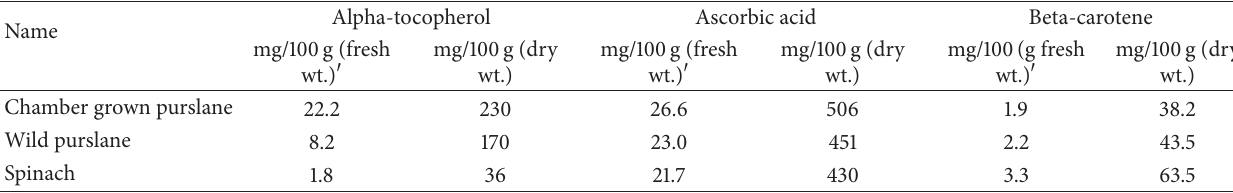
Table 6: Antioxidant content of purslane and spinach leaves.